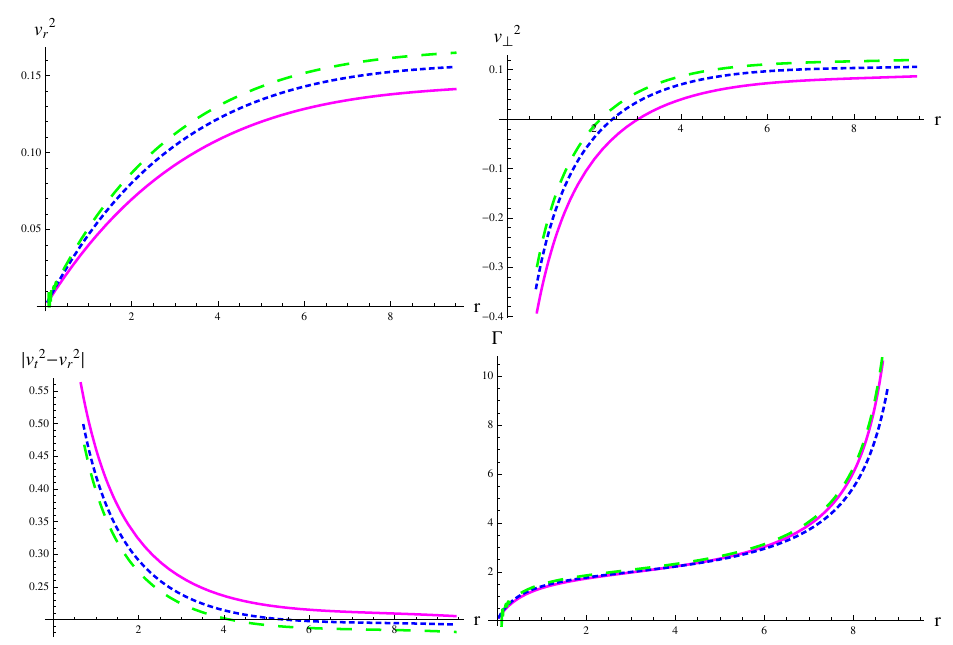
Figure 9. Plots of radial/tangential velocities, | v 2 ⊥ − v 2 r | and adiabatic index of extended solution I for Υ =